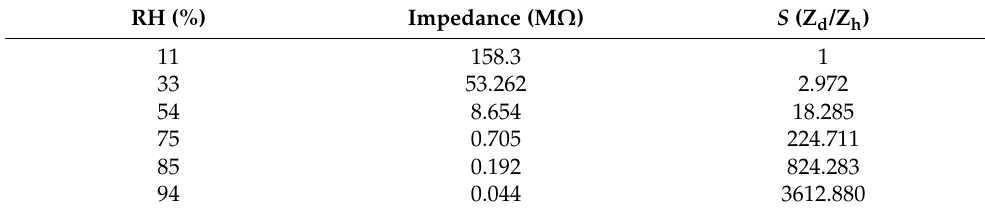
Table 2. Impedance and S values of the sensor based on nanosized HINO-0.005. RH